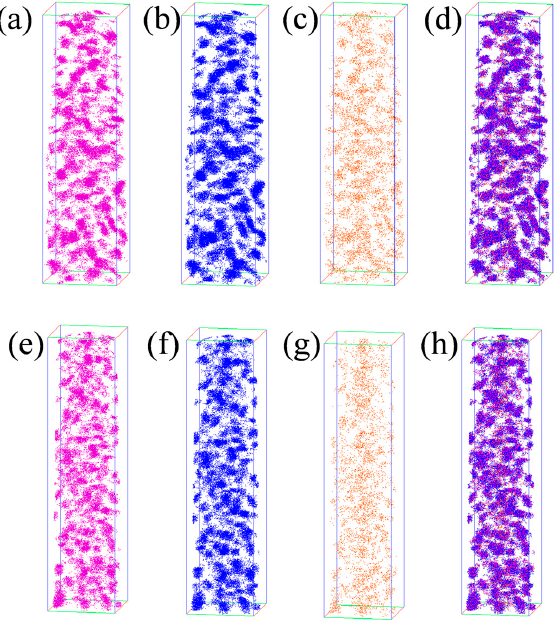
Figure 4. Distribution diagram of Zn, Mg, and Cu elements in T6- and T6-DCT-treated 7A99 alloy ( a ) Zn -T6; ( b ) Mg -T6; ( c ) Cu -T6; ( d ) Zn, Mg, and Cu -T6; ( e ) Zn T6-DCT; ( f ) Mg T6-DCT; ( g ) Cu T6-DCT; and ( h ) Zn, Mg, and Cu T6-DCT.